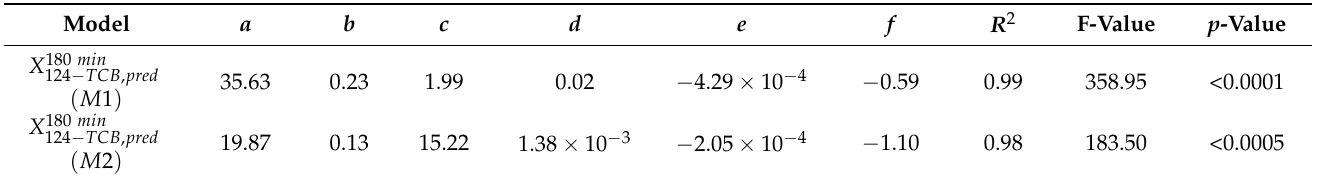
Table 2. Coefficients of the Response Surface Models M1 and M2 proposed. The coefficient of variation (R 2 ), Fischer’s test value (F-value), and probability ( p -value) obtained from ANOVA tests are also shown.